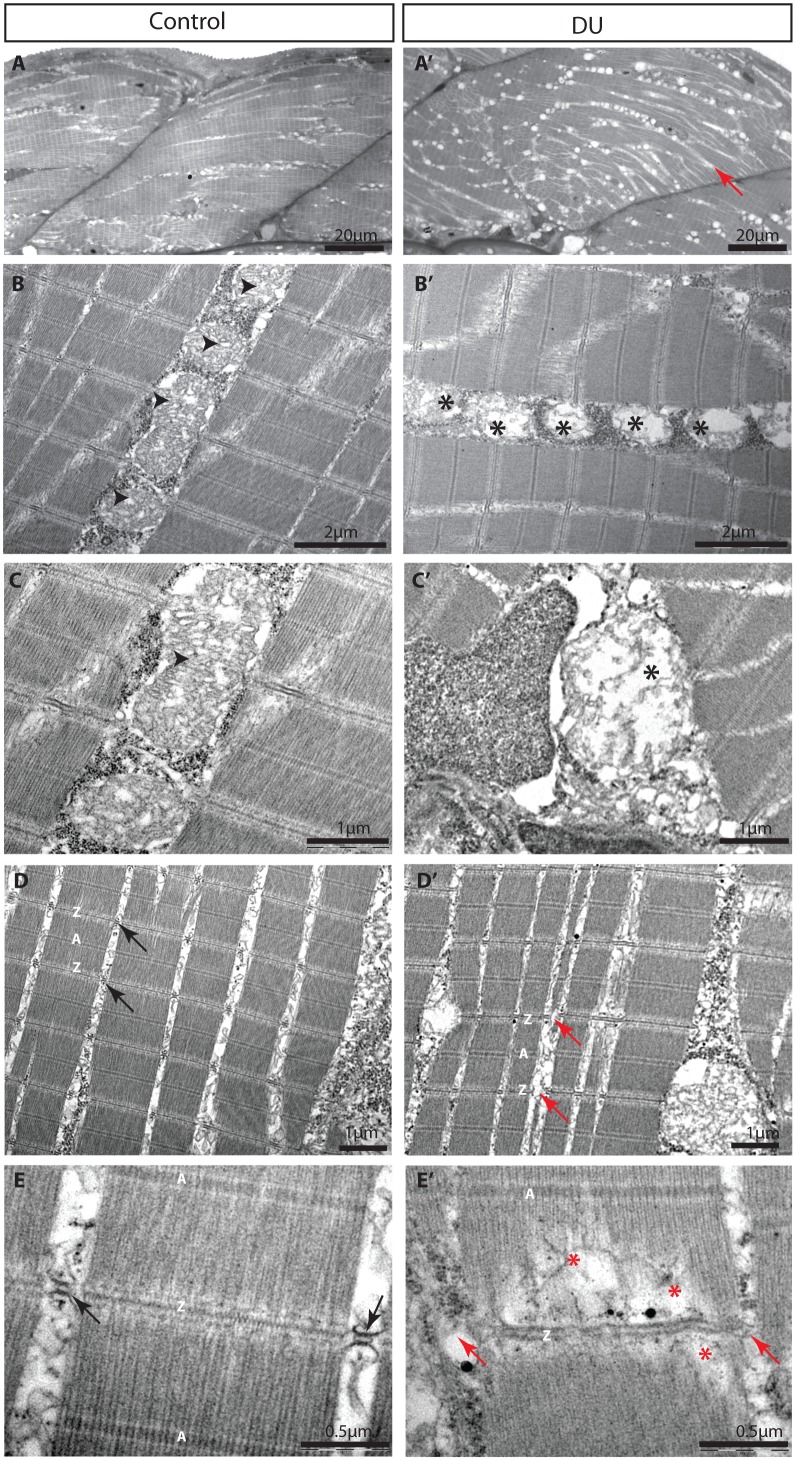
Histological analysis of 96 hpf larvae from DU-exposed adult fish compared to controls.(A-A’) Toluidine-blue staining of the larva at the level of the trunk. Vacuole-like structures (appearing as white dots) are abundant in DU-treated larvae compared to controls. (B-C) Mitochondrial morphology in skeletal muscles observed by transmission electronic microscopy of control larvae. The inner mitochondrial membranes are dense and well visible (black arrow head). (B’-C’) Alteration of mitochondrial morphology and absence or decreases density of inner mitochondrial membranes (*) in larvae from DU-exposed fish. (D-E) High-resolution transmission electronic microscopy of skeletal muscles in controls and (D’-E’) in the 96 hpf larvae obtained from DU-exposed fish. Disruption of myofibres (red asterisks) and swelling of Z-bands are visible in DU larvae. Z- and A-bands are indicated. Triads constituted of t-tubes and the two flanking cisterna of the sarcoplasmic reticulum are visible in the controls (black arrows) but are absent or deformed in larvae from DU-treated fish (red arrows).